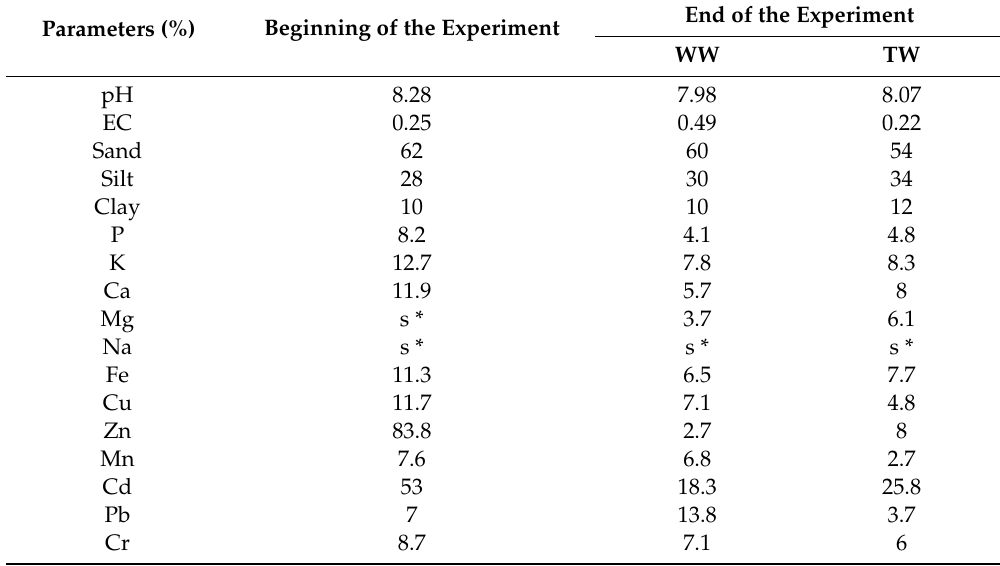
Table 2. Chemical and physical properties of soils at the beginning and end of the experiment. Parameters